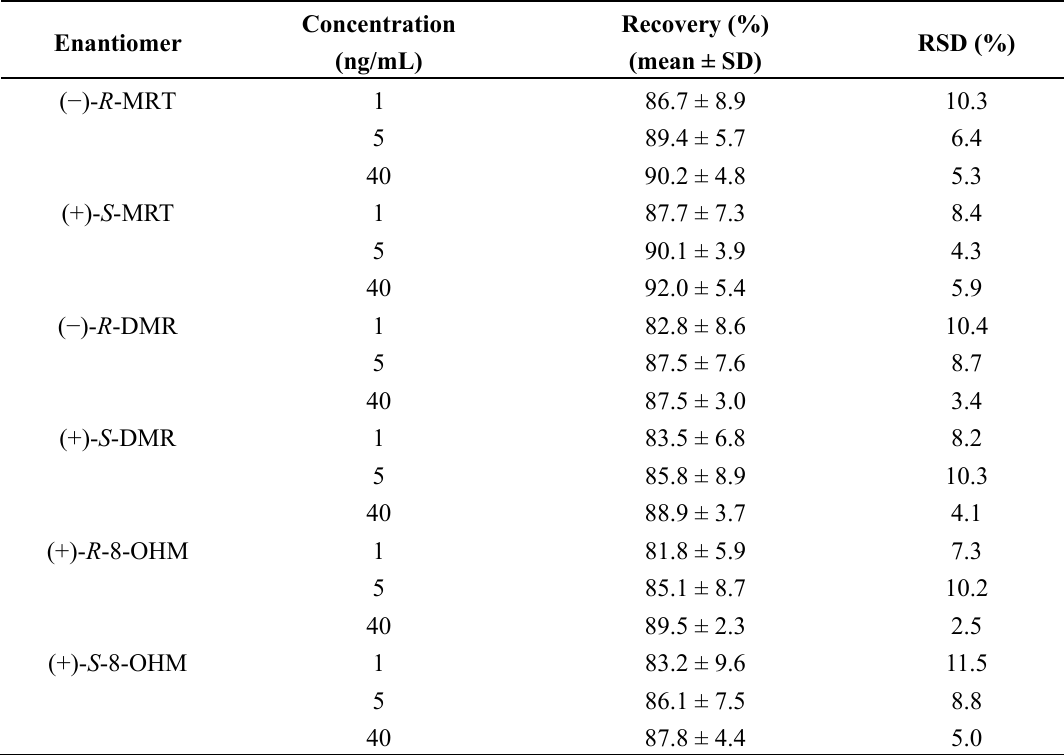
Table 4. Recoveries of MRT, DMR and 8-OHM enantiomers in human plasma (n = 5).